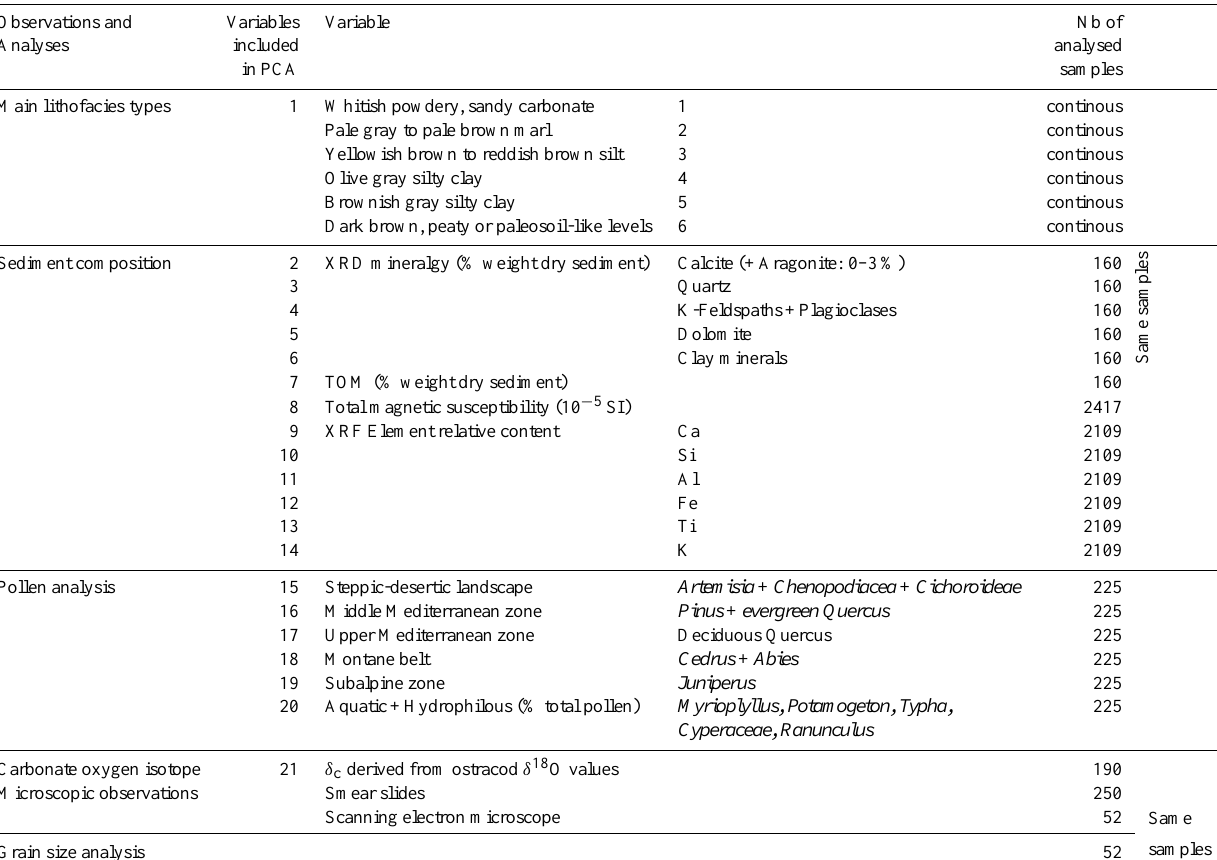
Table 2. Performed analyses on the upper 36m of core YAM04-C’. Variables included in the PCA PM analysis (Fig. 8) are numbered in column